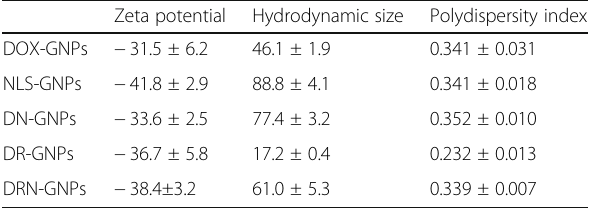
Table 1 The zeta-potential, hydrodynamic size,